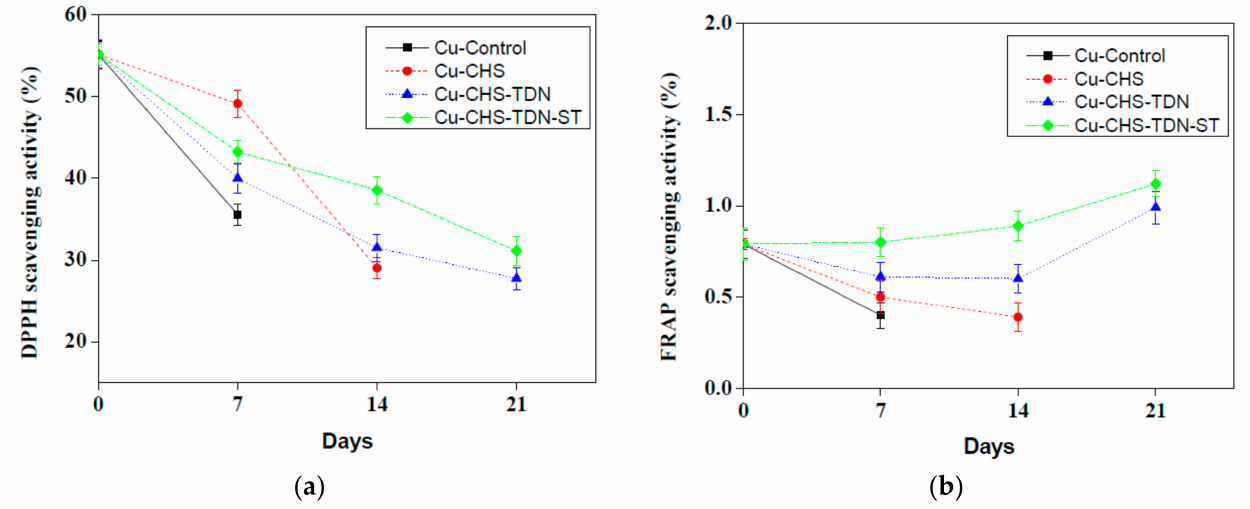
Figure 5. Effect of coating treatments on antioxidant activities; ( a ) DPPH and ( b ) FRAP scavenging activities.